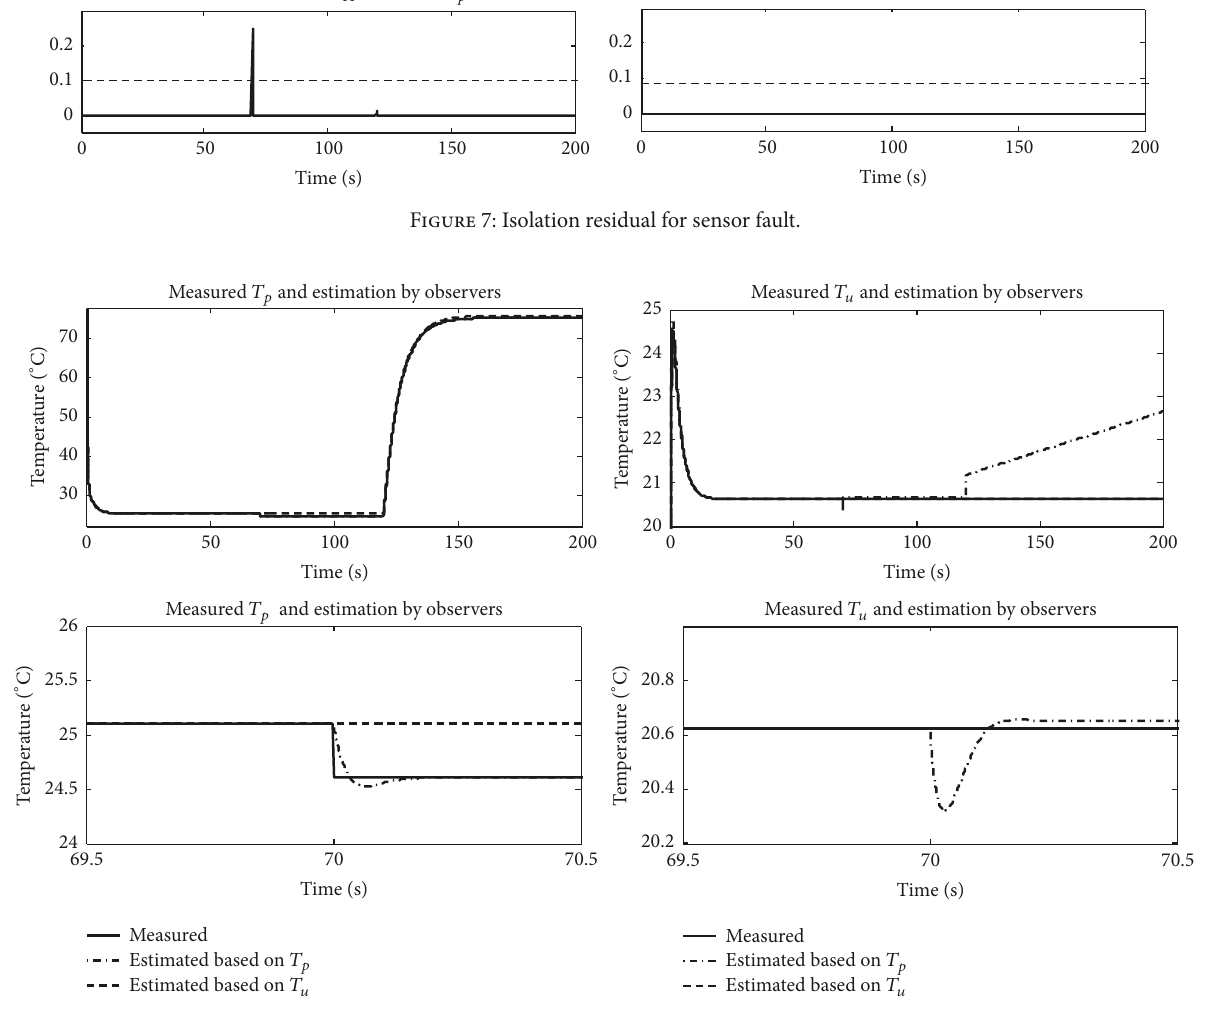
Figure 8: Temperature output by sensors and